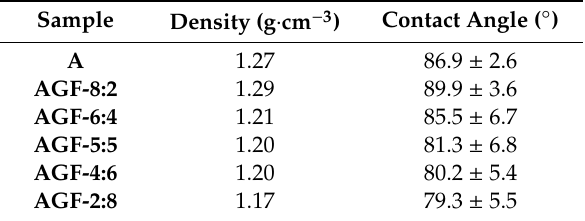
Table 12. The densities of prepared PETG composites with EG and CFs at the total loading of 10 wt.%.